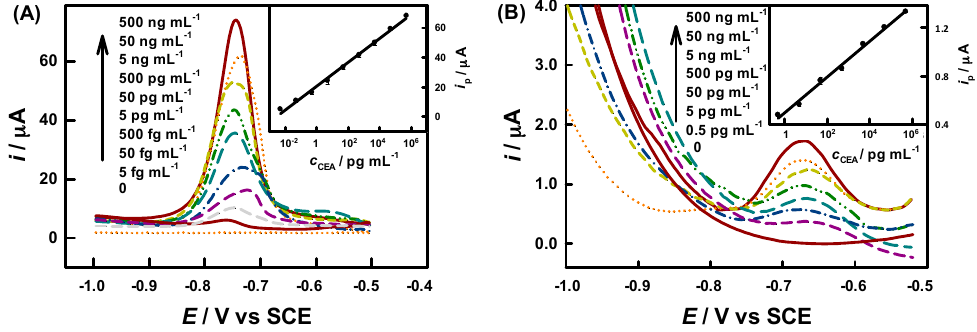
Figure 3. Differential pulse ASV curves for CEA immunoassay ( A ) for our protocol and ( B ) for the conventional protocol) and corresponding calibration curves (inset, n = 3).